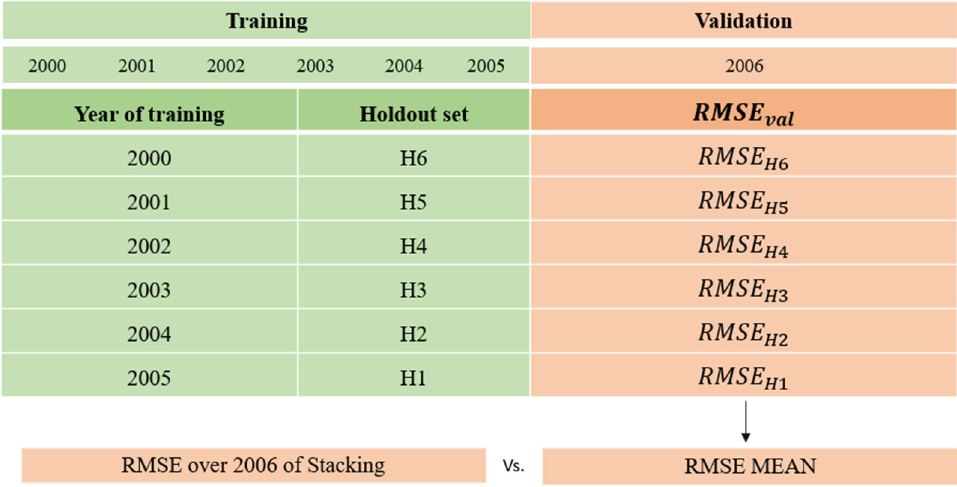
Figure 4. Test I with 6 years available in the data set. RMSEval is the error over the validation set (2006) and RMSE Hi is the error made by the model trained with the Hold-out set Hi.